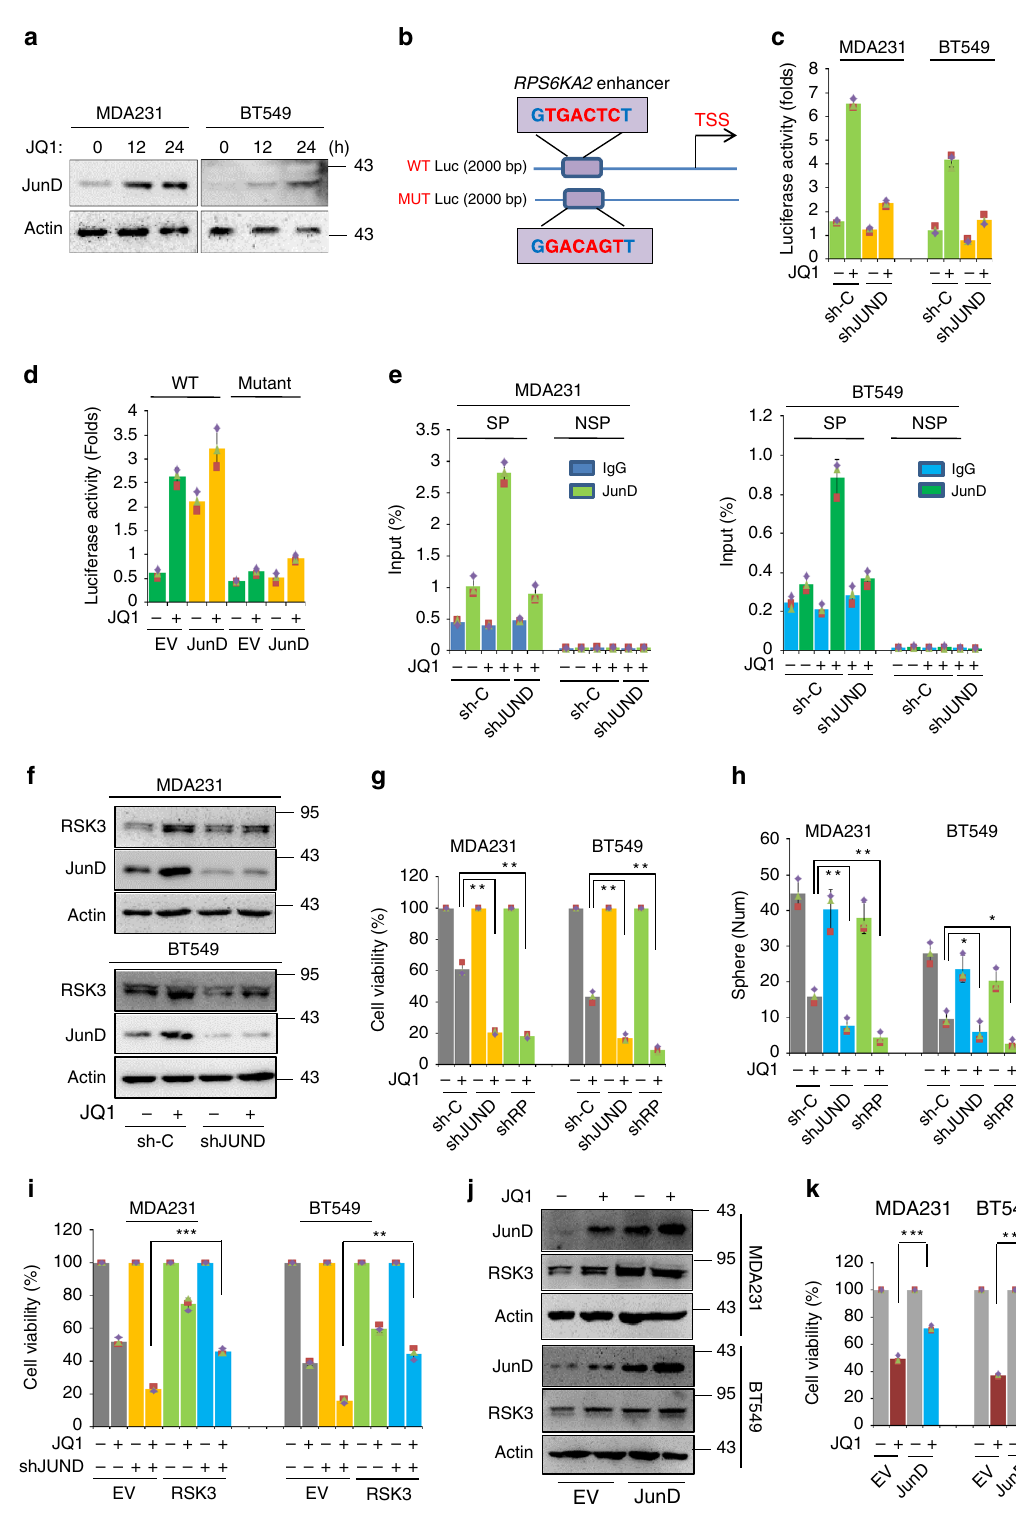
548d-3p was highly upregulated in BLBC cells which was con- fi rmed by real-time PCR in an array of breast cancer cell lines (Supplementary Fig. 4F), and bioinformatics analysis of The Cancer Genome Atlas (TCGA) indicated that the expression of MIR548D1 is uniquely and robustly upregulated in the